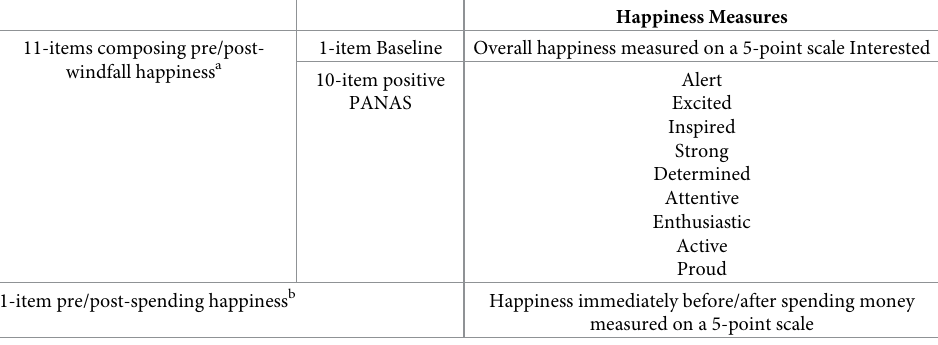
Table 1. Happiness measures used as dependent measures and covariate in the original and replication studies.